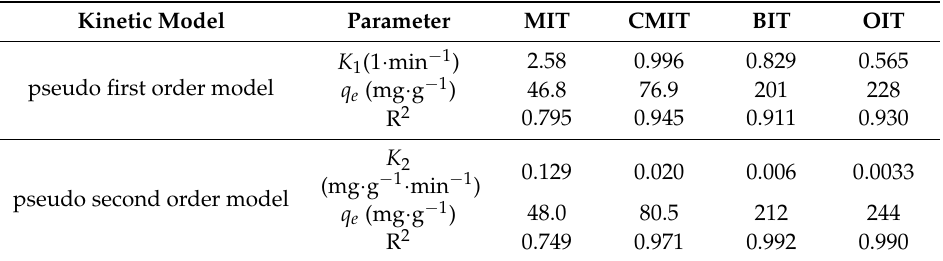
Table 1. Parameters calculated from kinetic models.